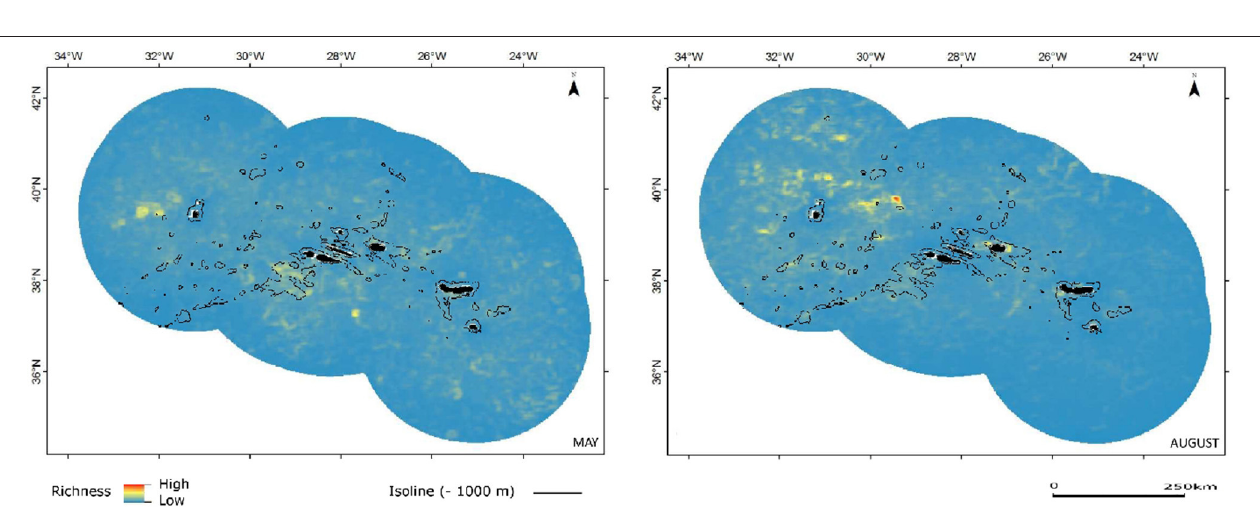
FIGURE 4 | Combined predicted richness of baleen whales in spring (May) and summer (August). Color scheme as in Figure 3 .